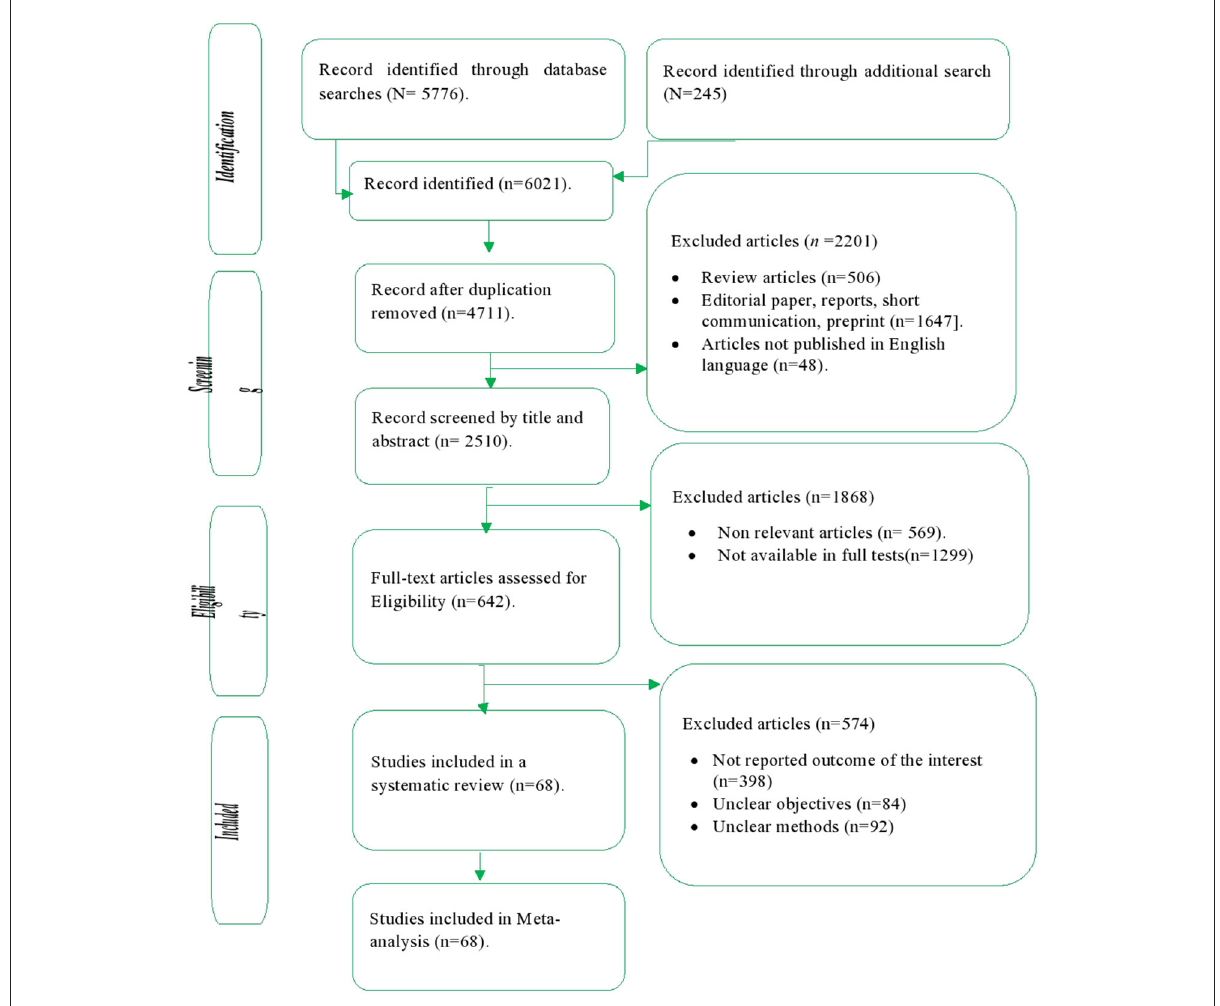
FIGURE2 Study selection process of included articles for systematic review and meta analysis,